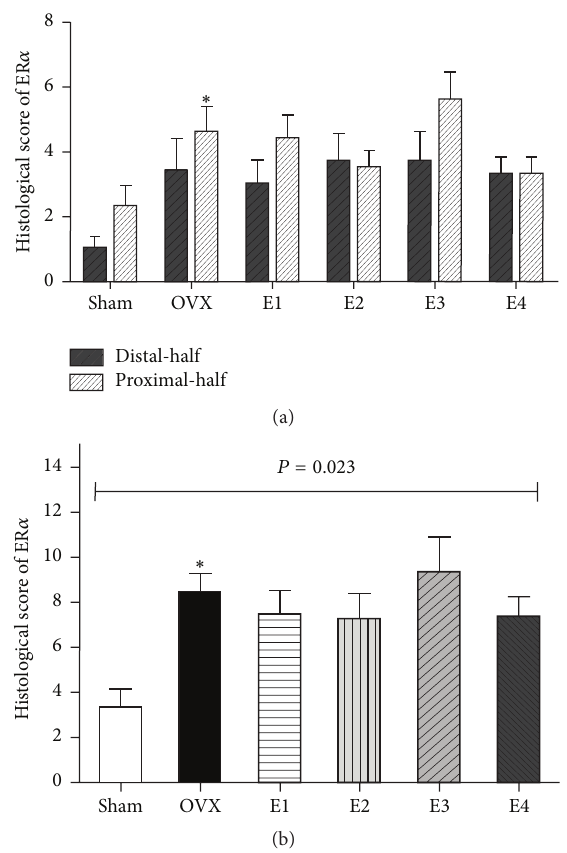
Figure 3: Histological scores of ER 𝛼 in the distal- and proximal- half areas. (a) presents the histological scores of ER 𝛼 in the distal- and proximal-half areas in each group. (b) presents the histological scores of ER 𝛼 in the whole vagina in each group. ∗ 𝑃 = 0.039 : ER 𝛼 score in the whole vagina is significantly higher in the OVX group than in the sham group (Mann-Whitney U